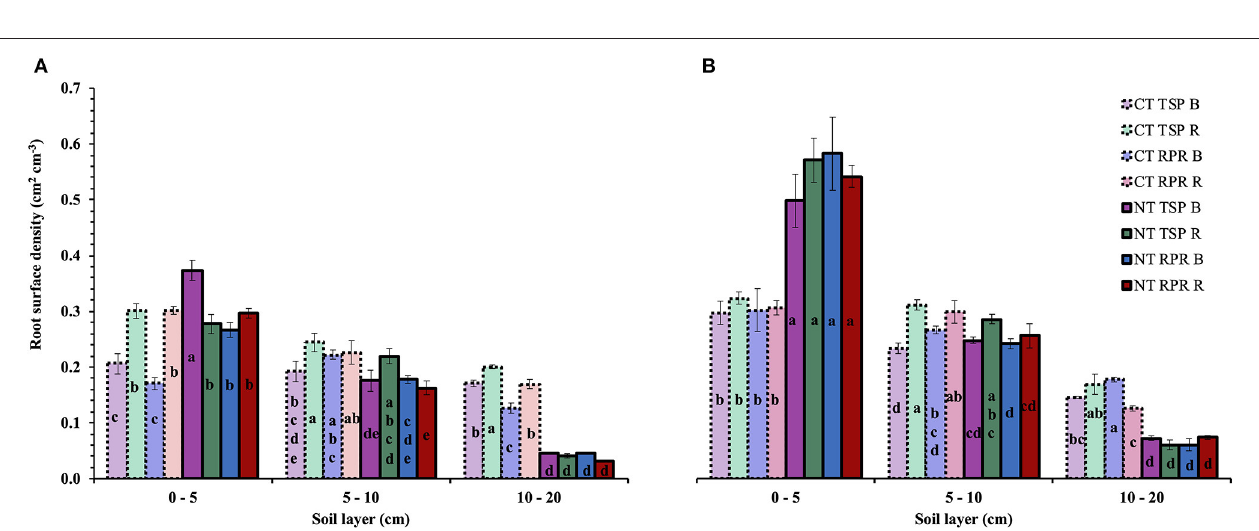
FIGURE 3 | Surface density of soybean (A) and corn (B) roots in three layers of a very clayey Oxisol under different soil tillage systems and phosphate fertilization management. Letters compare treatments in the same soil layer according to the LSD test (P < 0.05). NT, no tillage; CT, conventional tillage; TSP, triple superphosphate; RPR, reactive phosphate rock; B, broadcast; R, row.